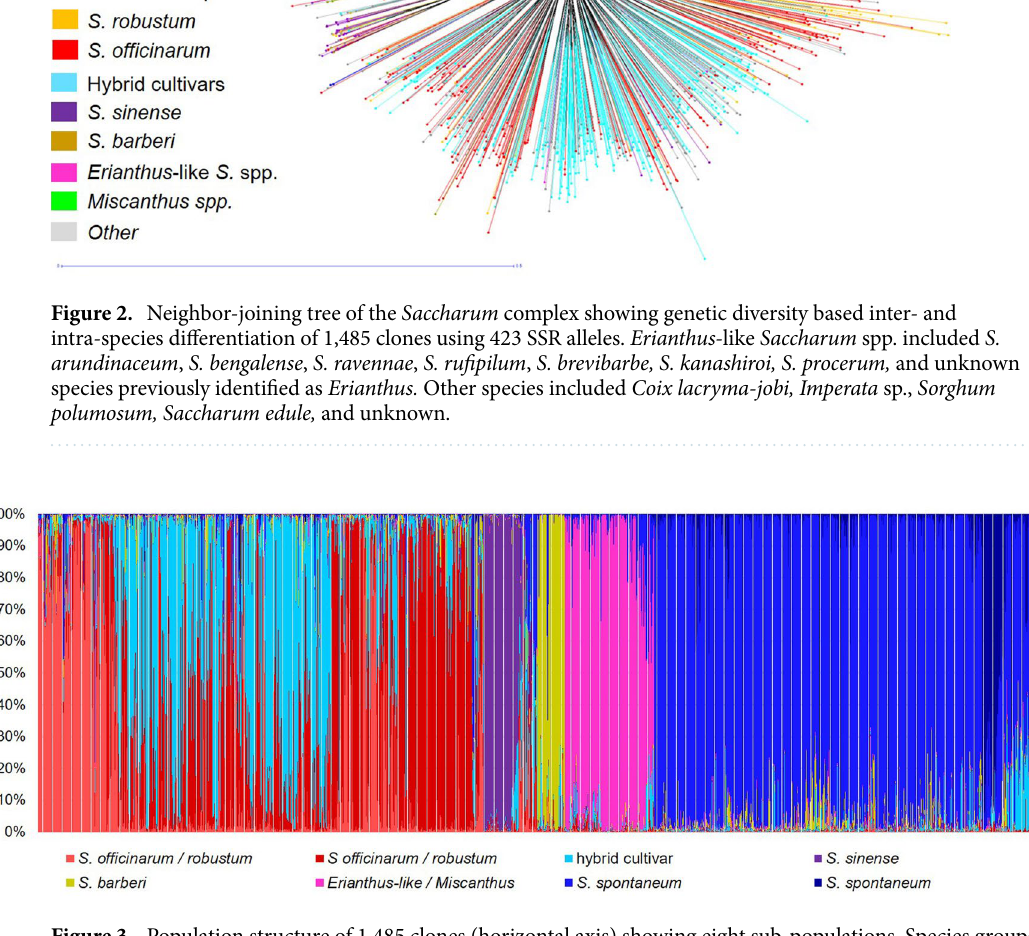
Figure 3. Population structure of 1,485 clones (horizontal axis) showing eight sub-populations. Species groups Saccharum officianarum / robustum, and S. spontaneum were each represented by two groups. Clones are in the order of the clones in the neighbor joining analysis for comparison (Fig. 2). Erianthus- like Saccharum spp. included S. arundinaceum , S. bengalense , S. ravennae , S. rufipilum , S. brevibarbe, S. kanashiroi, S. procerum, and unknown species previously identified as Erianthus. The values in the vertical axis represent the likelihood in percent of an individual belonging to one of the eight colored